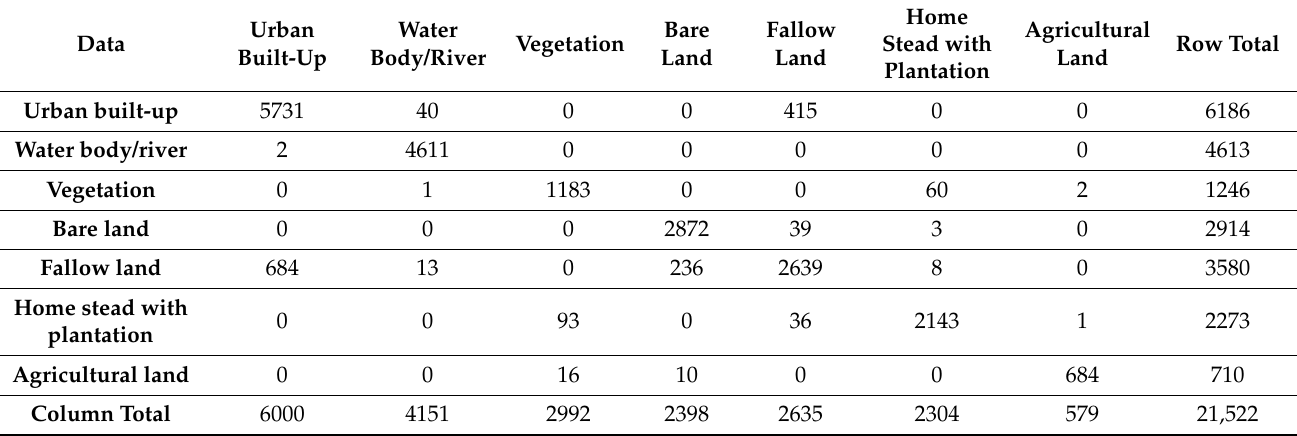
Table 4. Contingency matrix for land use and land cover,